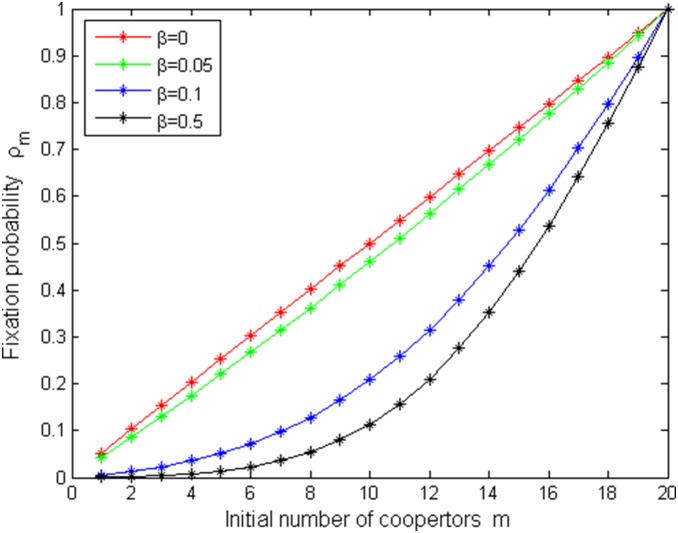
ρm vs N with µ = 1/4000, b = 1.2 and different β values.